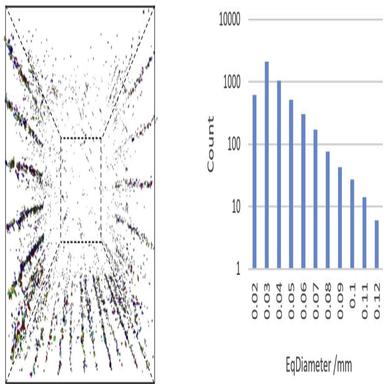
a) 3D image of pores within the cuboid structure, with a bounding outline to show the approximate position of the cuboid exterior, b) histogram showing the effective length of each pore.